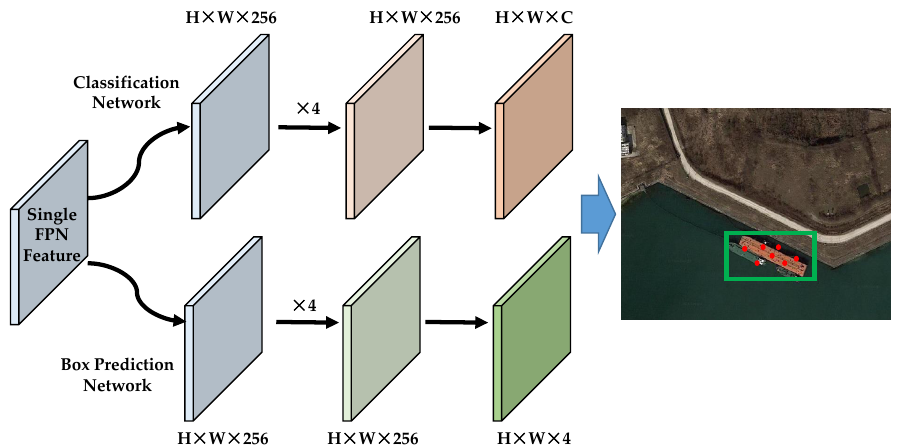
Figure 5. Two branch networks of the object prediction